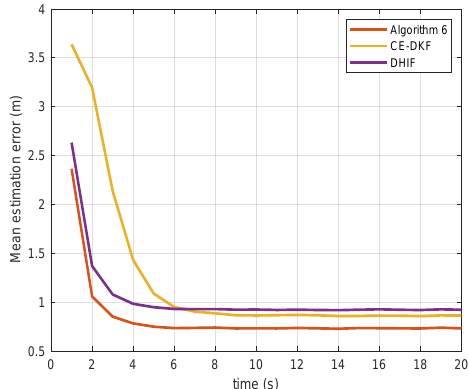
Figure 3. Mean estimation errors of different estimation algorithms ( Q = Q 2 ).